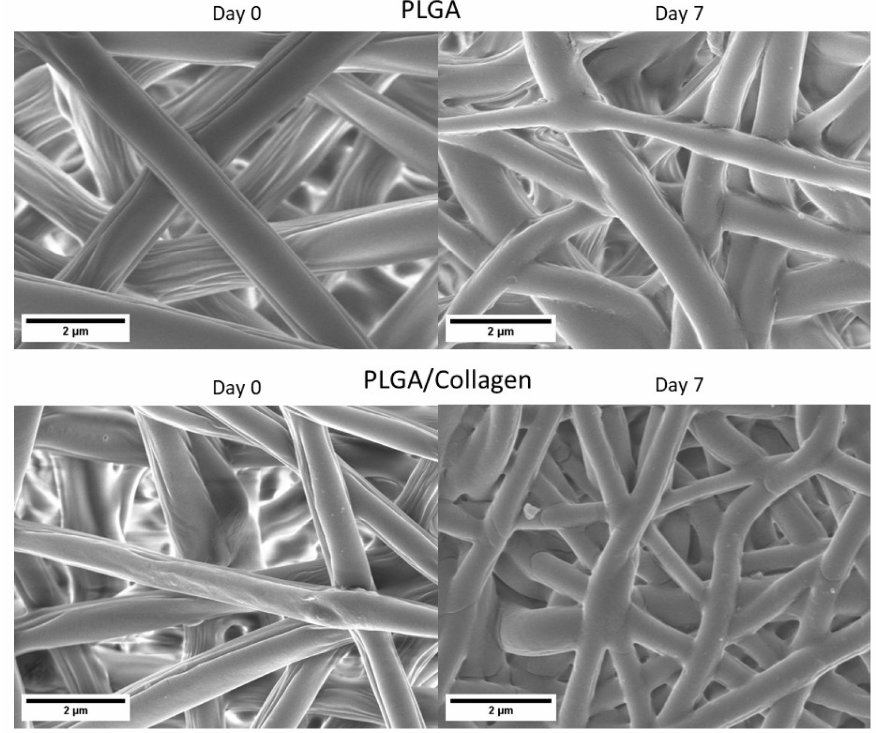
Figure 5. SEM images of enzymatic degradation of PLGA and PLGA/collagen scaffolds after 7 days of exposure to PBS and